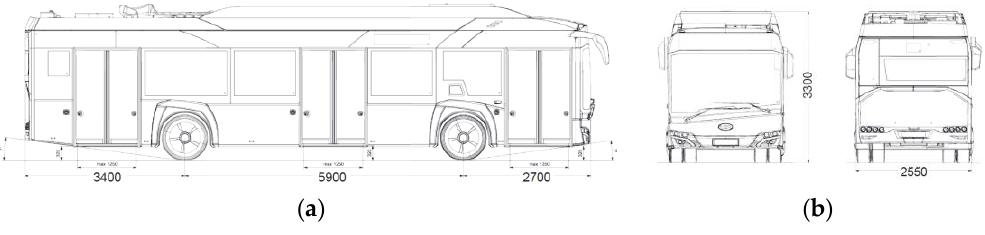
Table 1. Main technical data of the Solaris 12 E bus.